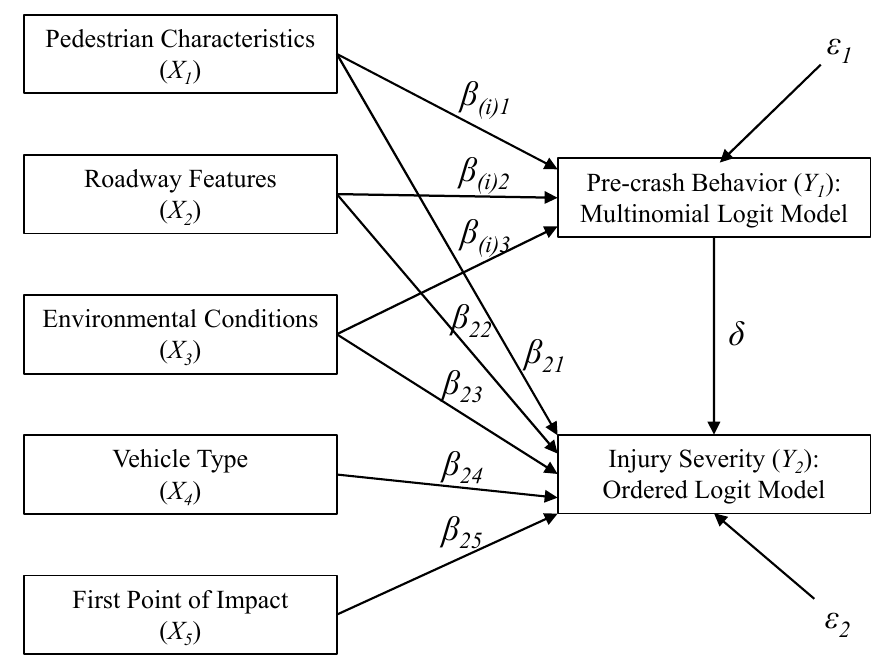
ff ects of various factors on the injury